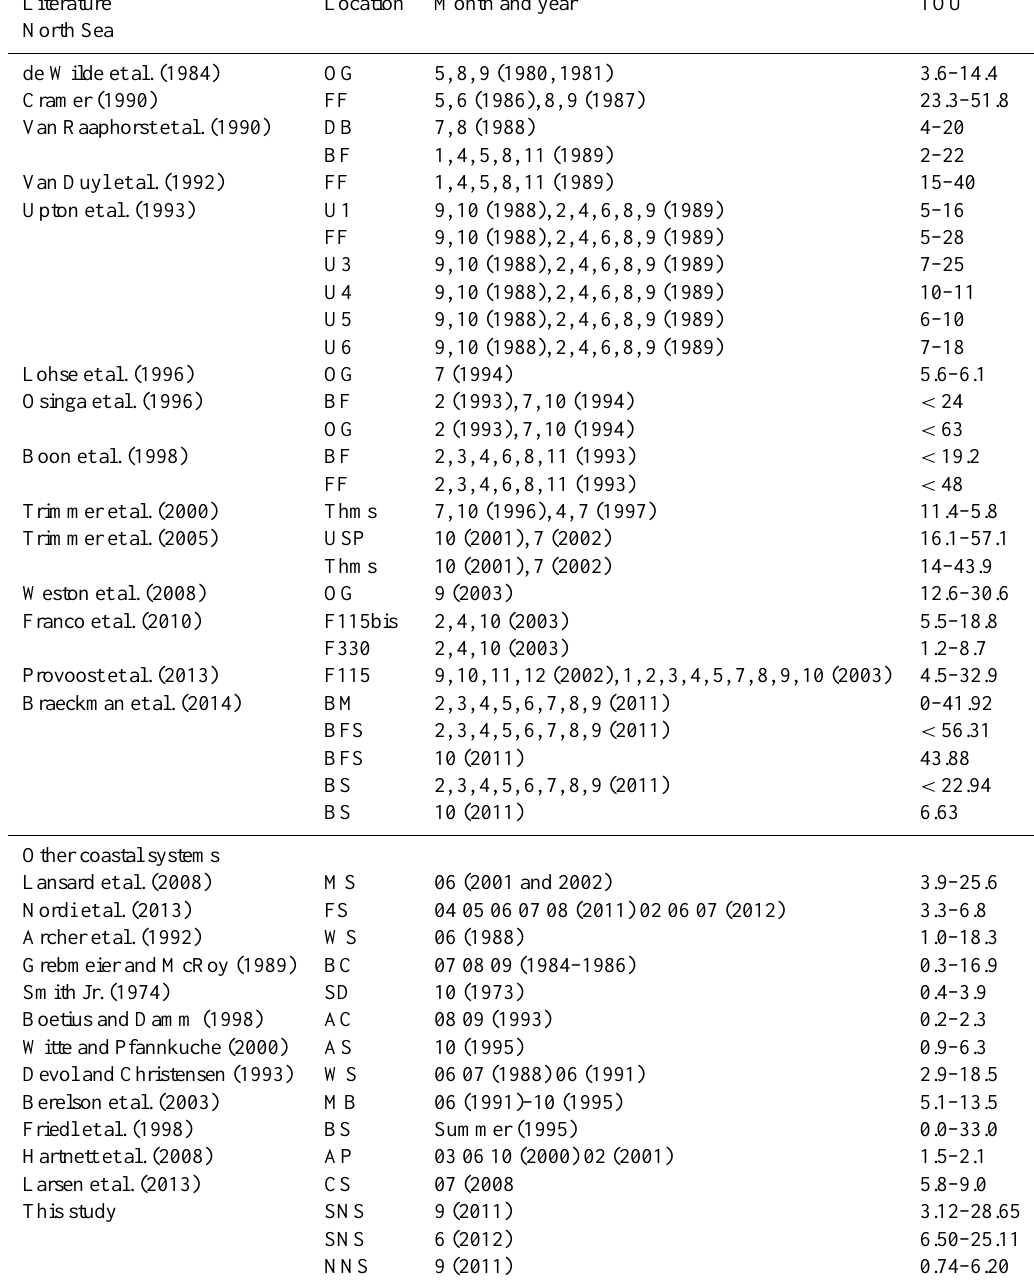
Table 4. TOU rates (mmolO 2 m − 2 d − 1 ) measured in the North Sea and other coastal systems taken from the literature compared to this study. OG: Oyster Ground; FF: Frisian Front; DB: Dogger Bank; BF: Broad Fourteens; U1–U3: (near) English Channel; U4–U6: central North Sea; F115bis, F330, BM, BFS, BS: Belgian coast; Thms: Thames; USP: Outer Silver Pit; MS: Mediterranean Sea; FS: Faroe